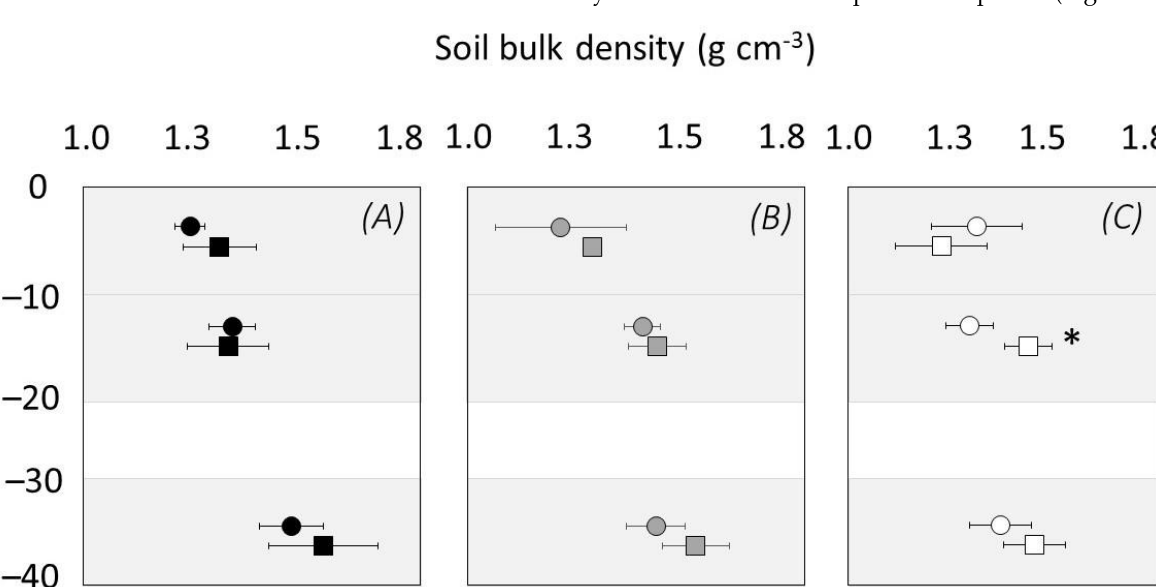
Figure 2. Number of IWG plant individuals per square meter in June and September 2020: ( A ), the weed biomass ( B ), the yield of beetroot ( C ) and average bulb weight ( D ) in September 2020. Data are presented as means (N = 4) with standard error deviations. Different lower-case letters indicate the significant difference in number of IWG in April 2020. Different upper-case letters indicate significant differences in September 2020 between the different strategies for terminating Kernza (AP, autumn ploughed; AH, autumn harrowing; SH, spring harrowing).